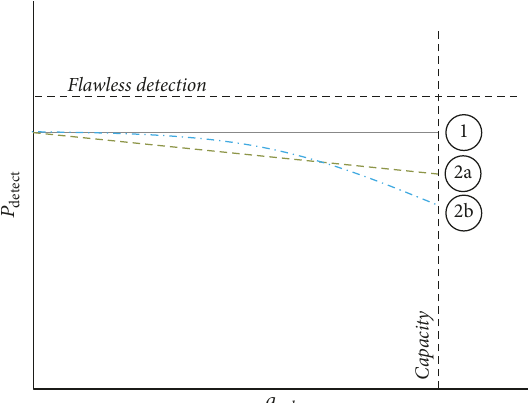
Figure 2: Visualisation of the possible mathematical descriptions of the counting error, where 1: uncorrelated with the flow, 2: linear, and 3: